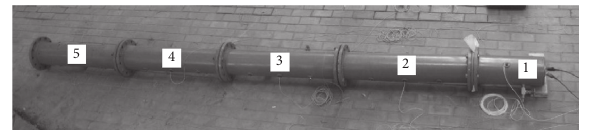
Figure 1: Experimental pipeline